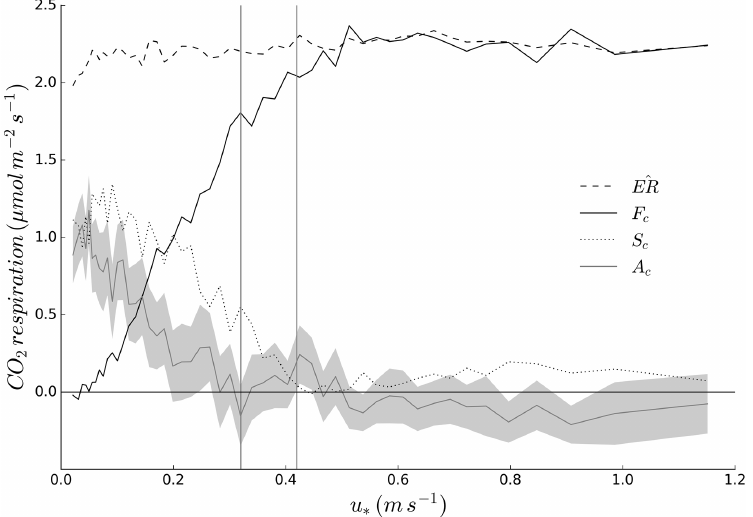
Figure 7. Dependence of measured ( F c , S c ) , model-estimated ( c ER ) and inferred ( A c ) mass balance components on friction velocity ( u ∗ , the grey shaded area represents the 95% confidence interval for the sample bin mean of the inferred advection components). Vertical lines denote u ∗ th for both F c and F c + S c , as per Fig. 5.